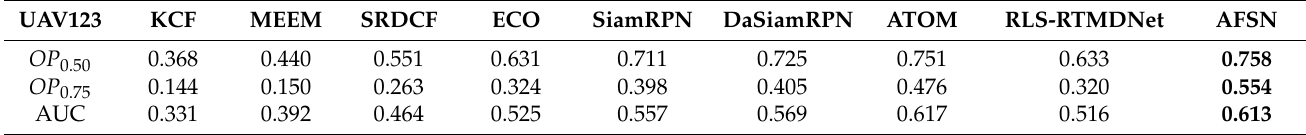
Table 2. Comparisons on the UAV123 dataset in terms of AUC and mean OP , given the thresholds 0.50 ( OP 0.50 ) and 0.75 ( OP 0.75 ). KCF: Kernelized Correlation Filter; MEEM: Robust Tracking via Multiple Experts Using Entropy